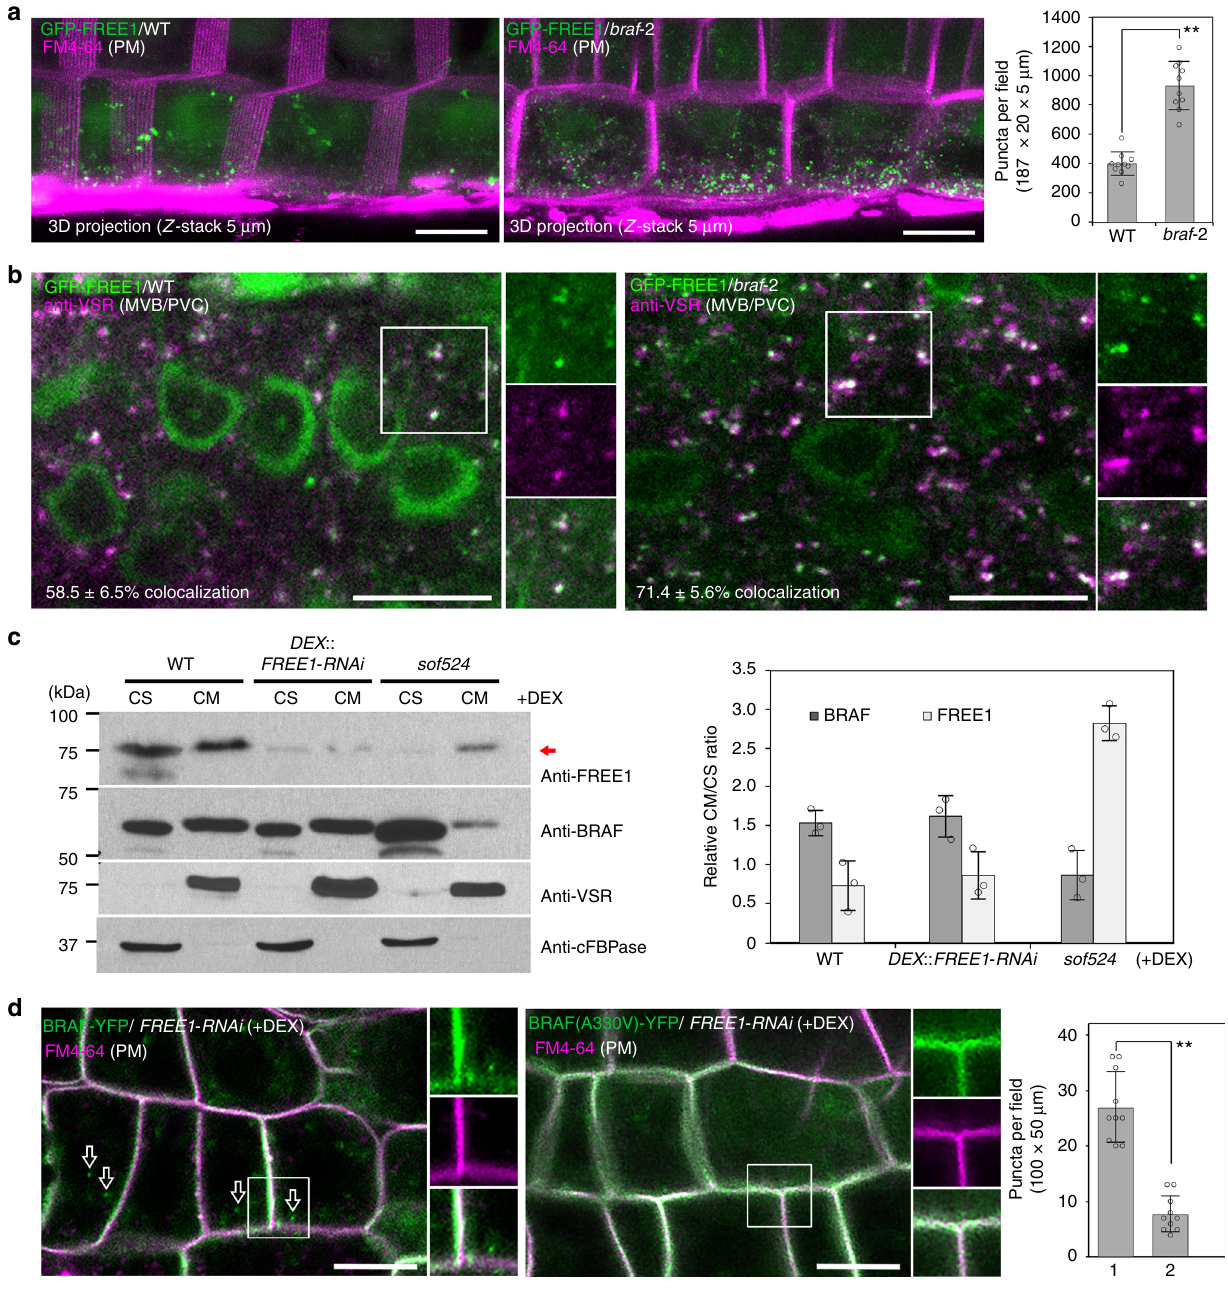
Fig. 5 BRAF regulates FREE1 recruitment to MVB/PVCs. a The number of GFP-FREE1 punctae in braf mutant was increased compared to WT. Confocal images were collected from the root epidermal cells of the basal meristem region. Analysis of the number of GFP-FREE1 punctae per root section by Z -stack projection is quanti fi ed on the right. Ten slices were collected in a total thickness of 5 μ m for generating the 3D projection image. FM4-64 was used to label and visualize the cell plasma membranes (PM). The results were obtained from 10 individual seedlings. Error bars represent the S.D. of puncta per fi eld. ** P < 0.01 in Student ’ s t -test. Scale bars, 10 μ m. b The GFP-FREE1 punctae in braf mutant localizes to MVB/PVCs. Immuno fl uorescent labeling with the MVB/ PVC marker anti-VSR antibody in WT or braf-2 mutant expressing GFP-FREE1. Colocalization was quanti fi ed from fi ve individual labeling roots. The percentage of anti-VSR-labeled MVB/PVCs with GFP-FREE1 vesicle colocalization is included in the bottom. Total numbers of vesicles counted were n = 1245 in WT, and n = 1265 in braf-2 mutant. Scale bars, 10 μ m. c The sof524 mutation enhanced FREE1 cell membrane distribution. Immunoblot and quanti fi cation analysis of the FREE1 and BRAF membrane association in WT, DEX::FREE1-RNAi , and sof524 plants. The FREE1 or BRAF intensity was normalized by the loading control of anti-VSR as cell membrane (CM) fraction and anti-cFBPase as cell soluble (CS) fraction, and the CM/CS ratio of FREE1 or BRAF in indicated genotype seedlings was quanti fi ed on the right. Note the increased FREE1 distribution in CM fraction of sof524 seedlings as indicated by the arrow. Error bars are the S.D. from three independent experiments. d The BRAF(A330V) mutation disturbs its membrane association with the endosome, but not the PM. Confocal images were taken from root epidermal cells of 7-day-old seedlings of indicated genotypes after DEX induction. The numbers of intracellular punctae per root section of BRAF-YFP (column 1) or BRAF(A330V)-YFP (column 2) are quanti fi ed on the right. The results were obtained from 10 individual seedlings. FM4-64 was used as a plasma membrane (PM) marker. ** P < 0.01 in Student ’ s t -test. Scale bars, 10 μ